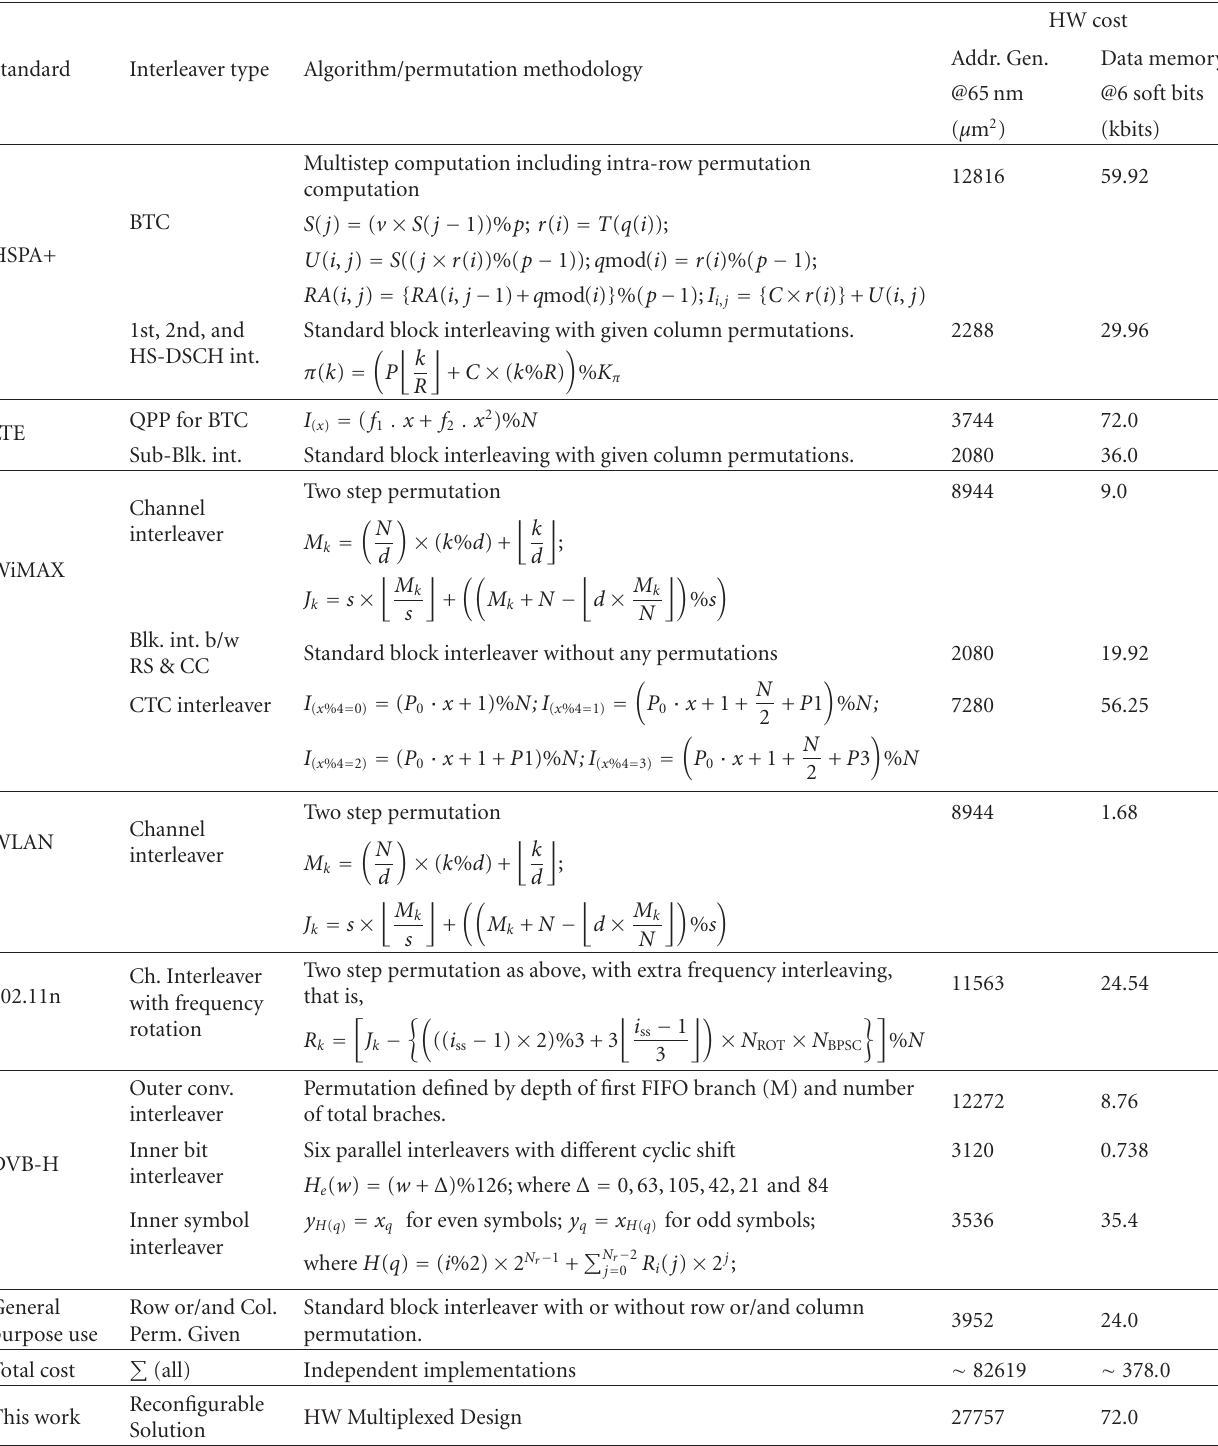
Table 1: List of algorithms and permutations in di ff erent interleaver implementations and the cost comparison.